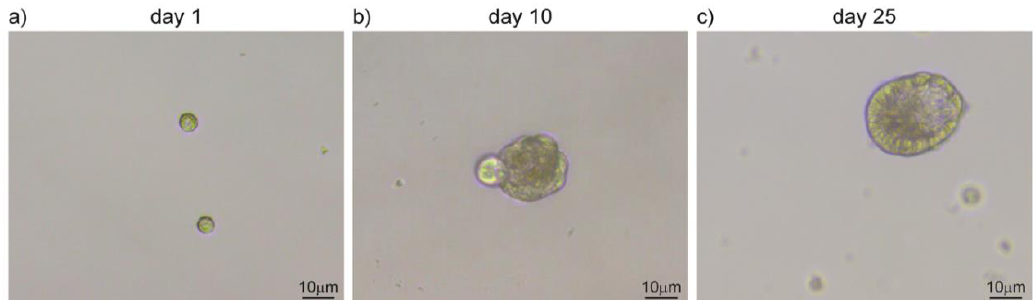
Figure 3. Salispheres culture from adult salivary glands. ( a ) Single-cell suspension upon submandibular gland dissociation. ( b ) Cells amplify in vitro and cluster together forming salispheres. ( c ) Salispheres grow larger and start to differentiate in duct-like structures. Original images from our lab.